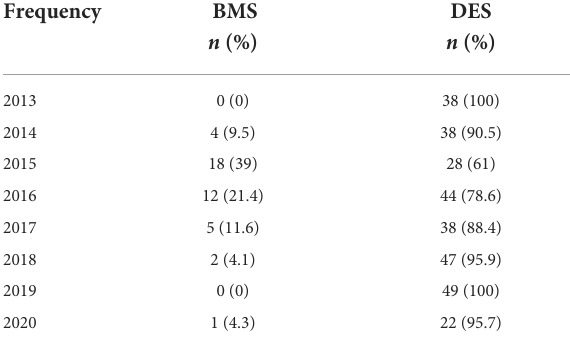
TABLE 7 Number of patients with BMS vs. DES per year